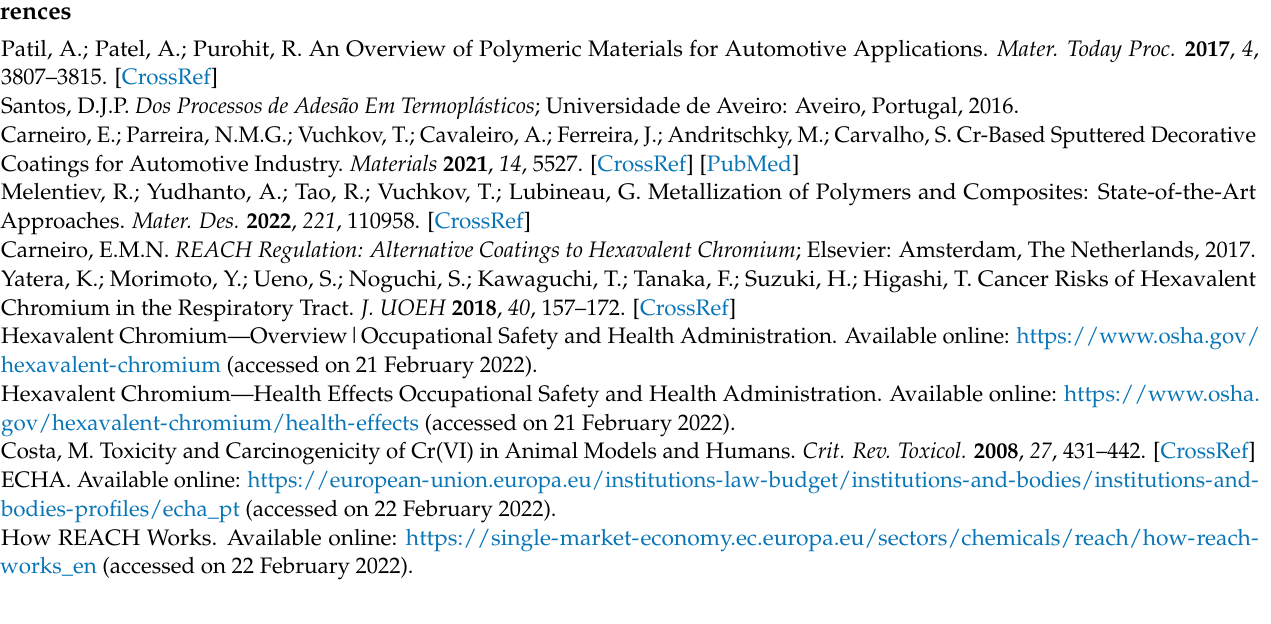
Figure S4. Microscopic images of Cr coatings on PCB samples using backlight mode for counting the number of